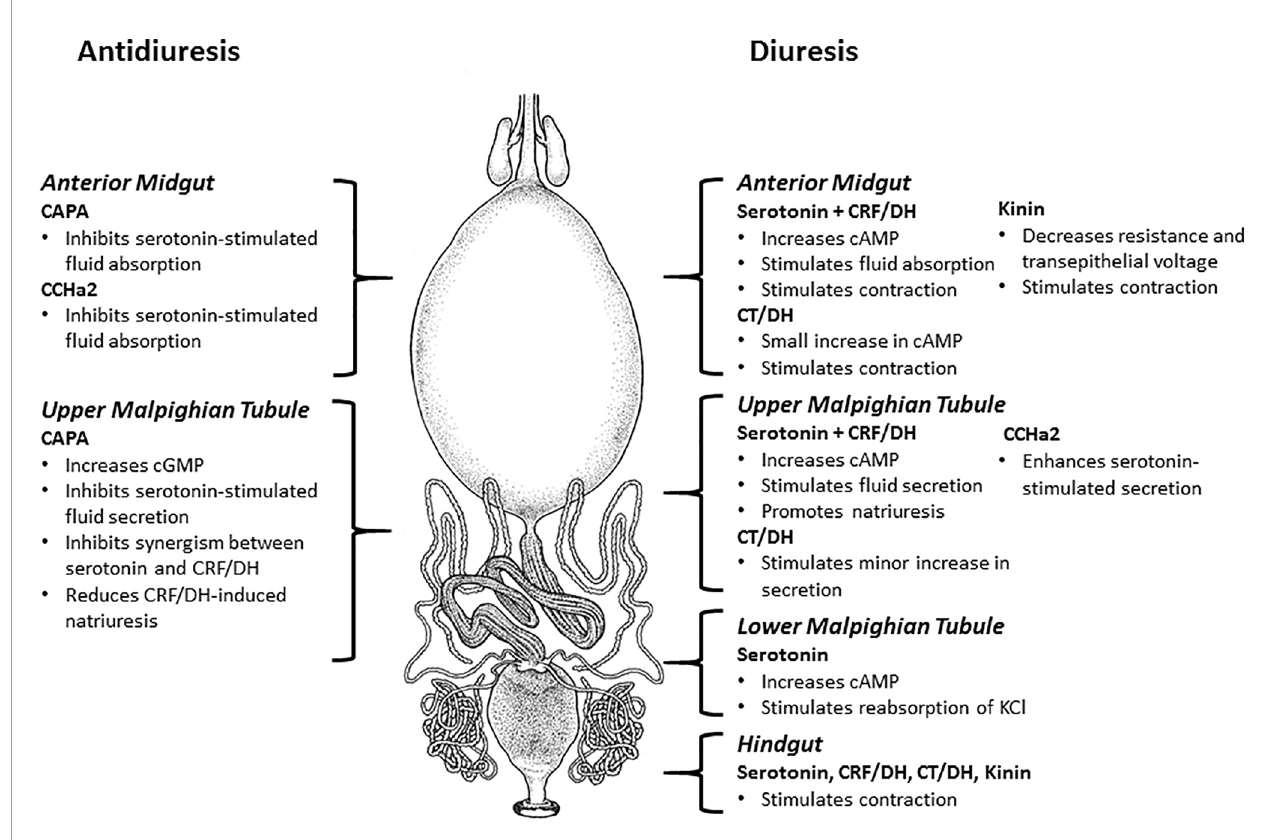
FIGURE 3 | Model depicting the neuroendocrine control of post-prandial diuresis and its termination by antidiuretic hormones in Rhodnius prolixus . Diuresis is controlled by serotonin and Rhopr-CRF/DH (corticotropin-releasing factor-related diuretic hormone) acting upon the anterior midgut (to stimulate absorption), and simultaneously on the distal (upper) portion of the Malpighian tubules (to stimulate secretion). Serotonin alone acts upon the proximal (lower) portion of Malpighian tubules to stimulate reabsorption of KCl. Rhopr-CT/DH (calcitonin-related diuretic hormone), which is co-released from the same neurosecretory cells that release serotonin, stimulates only a small increase in secretion by Malpighian tubules. Rhopr-K (Kinin) which is co-released from the same neurosecretory cells that release Rhop-CRF/DH decreases resistance and transepithelial voltage of the anterior midgut but does not stimulate absorption, and also does not stimulate secretion by Malpighian tubules. CCHa2 enhances serotonin-stimulated secretion by Malpighian tubules. Serotonin, Rhopr-CRF/DH, Rhopr-CT/DH and Rhopr-K all stimulate contractions of anterior midgut and contractions of hindgut. Diuresis is terminated by the release of Rhopr-CAPA2 (CAPA) which inhibits serotonin-stimulated absorption by anterior midgut, serotonin stimulated secretion by Malpighian tubules, and also eliminates the synergism between serotonin and Rhopr-CRF/DH. CCHa2 inhibits serotonin-stimulated absorption across the anterior midgut. References in